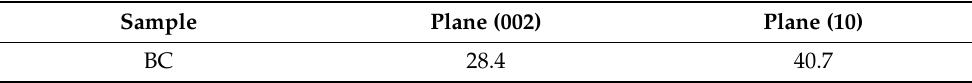
Figure 5. XRD spectral pattern of BC. Table 3. Peak position ( ◦ ) of BC on the 2 θ scale, as determined from the XRD pattern. Table 4. Structural information of BC, as determined from XRD patterns.